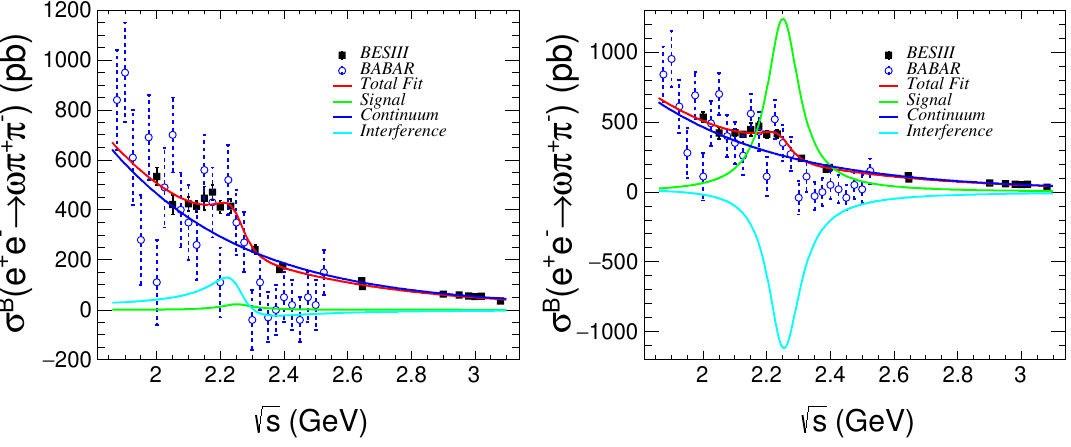
Figure 8 . Fits to the measured e + e − → ωπ + π − cross sections. The dots with error bars are the results obtained in the work, where the error bars include both statistical and systematic uncertainties. Circles with error bars (hatched line) are the results of the BaBar experiment. The red solid curve is the total fit result. The blue solid curve represents the continuum component, the green curve stands for the resonant component, and the cyan line is the interference of the two components. The two plots are the results of Solutions I (left) and II (right),